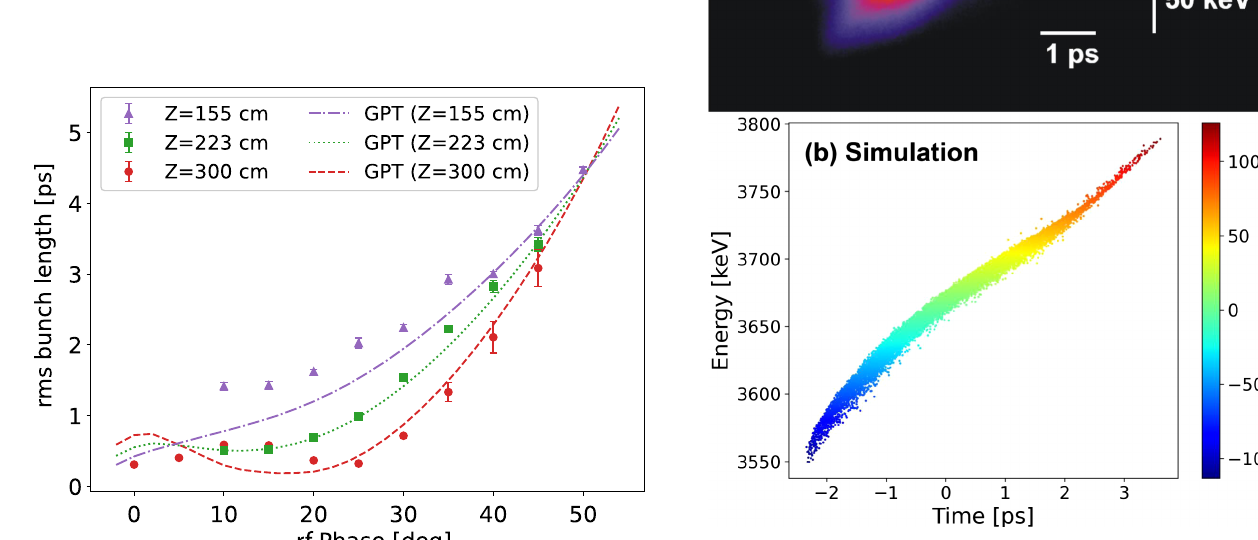
FIG. 7. Measured bunch lengths at three different positions as a function of the rf-accelerating phase. The dashed lines represent GPT simulations with a bunch charge of 100 pC.